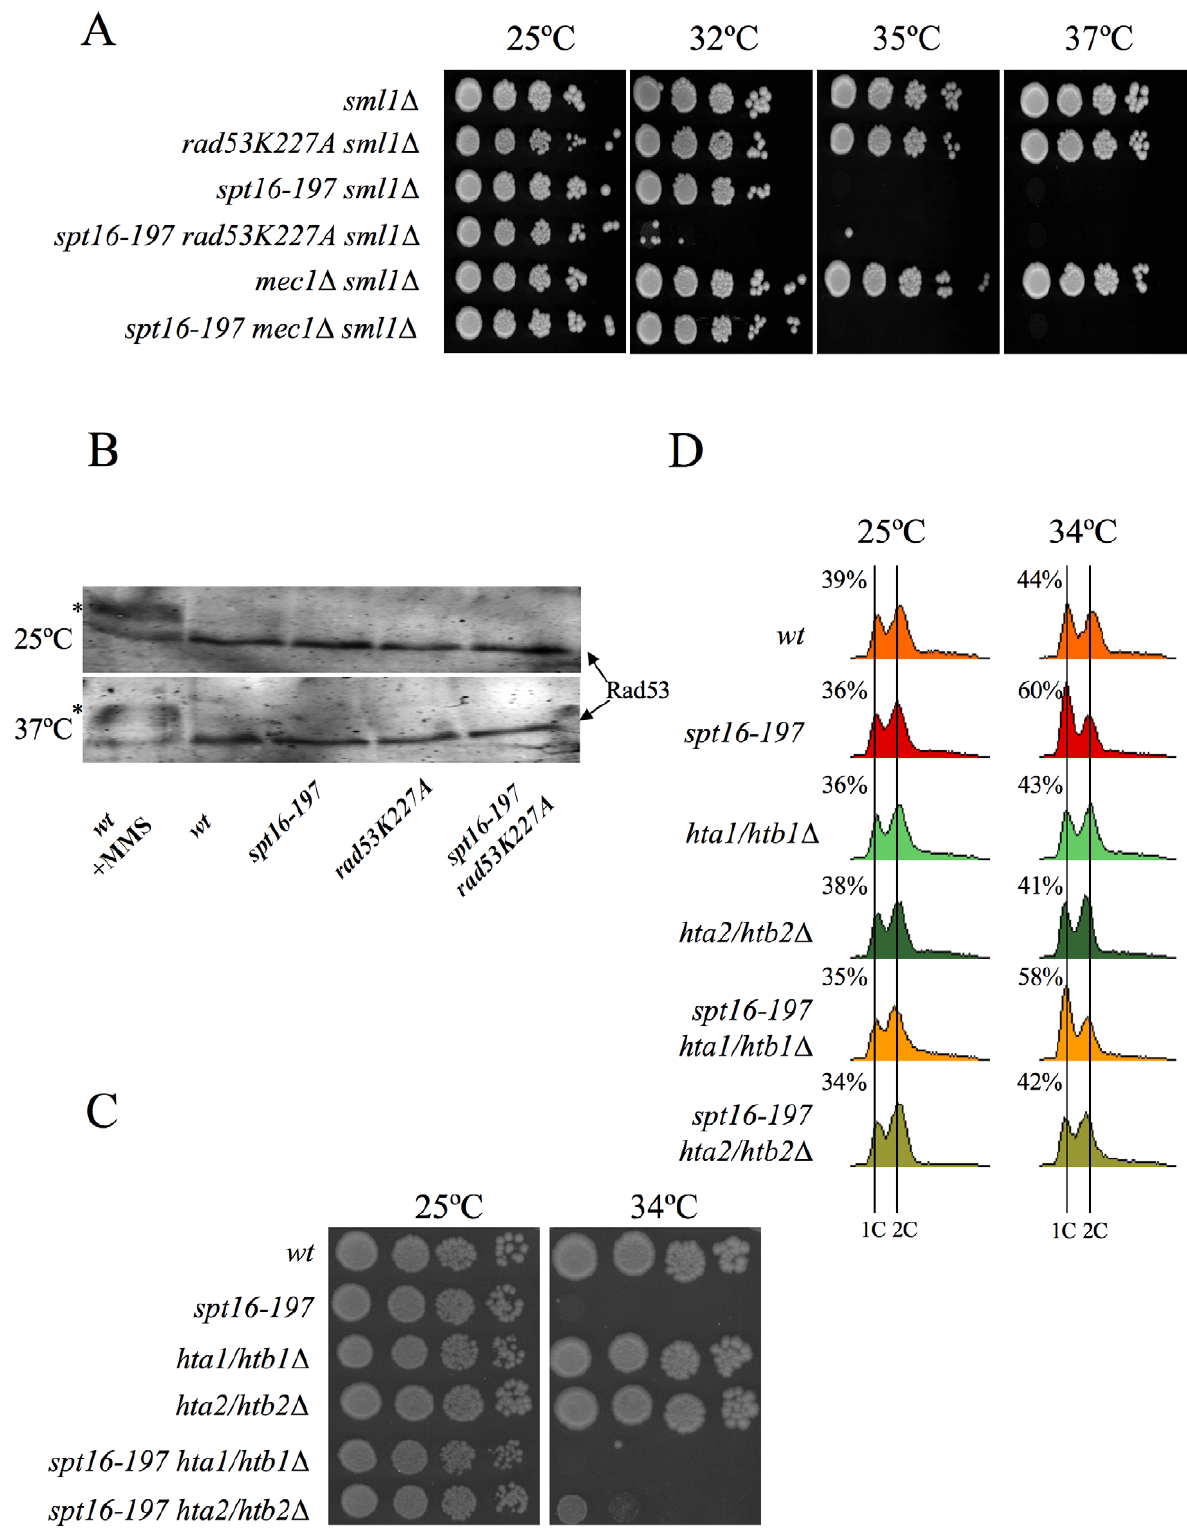
Figure 4. Genetic interactions connect FACT dysfunction to free histones. (A) rad53K227A enhances the thermosensitivity of spt16-197 , irrespectively of the DNA damage checkpoint. Strains VO1-1, VO1-2, VO1-3, VO1-5, VO1-6, and VO1-8 were grown in YPD medium at 25 u C. 10-fold serial dilutions were plated on YPD plates and incubated for 3 days at the indicated temperatures. (B) FACT dysfunction did not induce the hyperphosphorylation of Rad53p. The indicated strains (FY120, FY348, VO3, and VO7) were grown in YPD at either 25 u C or 37 u C for two hours. The TCA-treated protein extracts were analyzed by Western blot analysis with the goat anti-Rad53 polyclonal antibody. The hyperphosphorylation of Rad53 (shown by an *) was evidenced in the wild-type cells treated with 0.02% MMS. (C) hta2/htb2 D partially suppressed spt16-197 . Strains (FY120, PLoS Genetics |